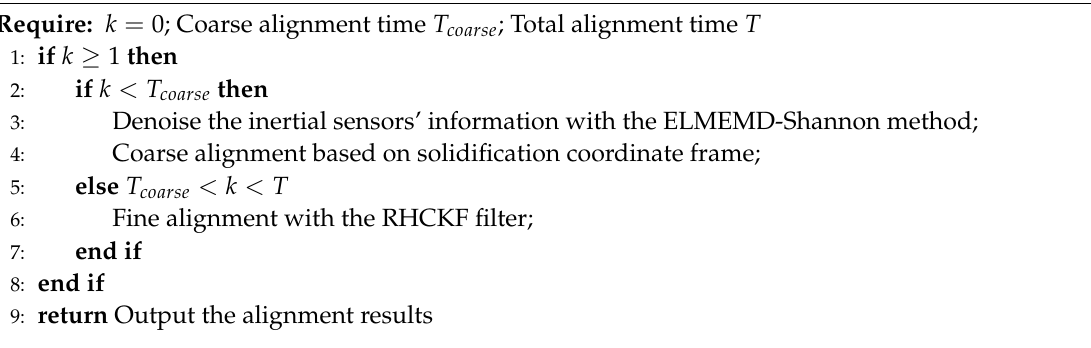
Algorithm 2 Improved Initial Alignment